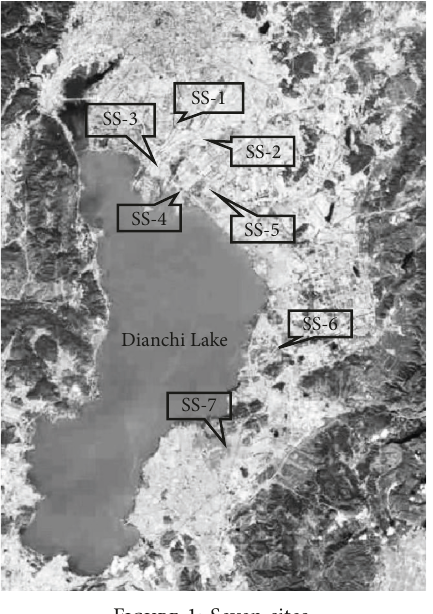
Figure 1: Seven sites. Table 1: Determination results of humic acid content in natural peat soil samples.